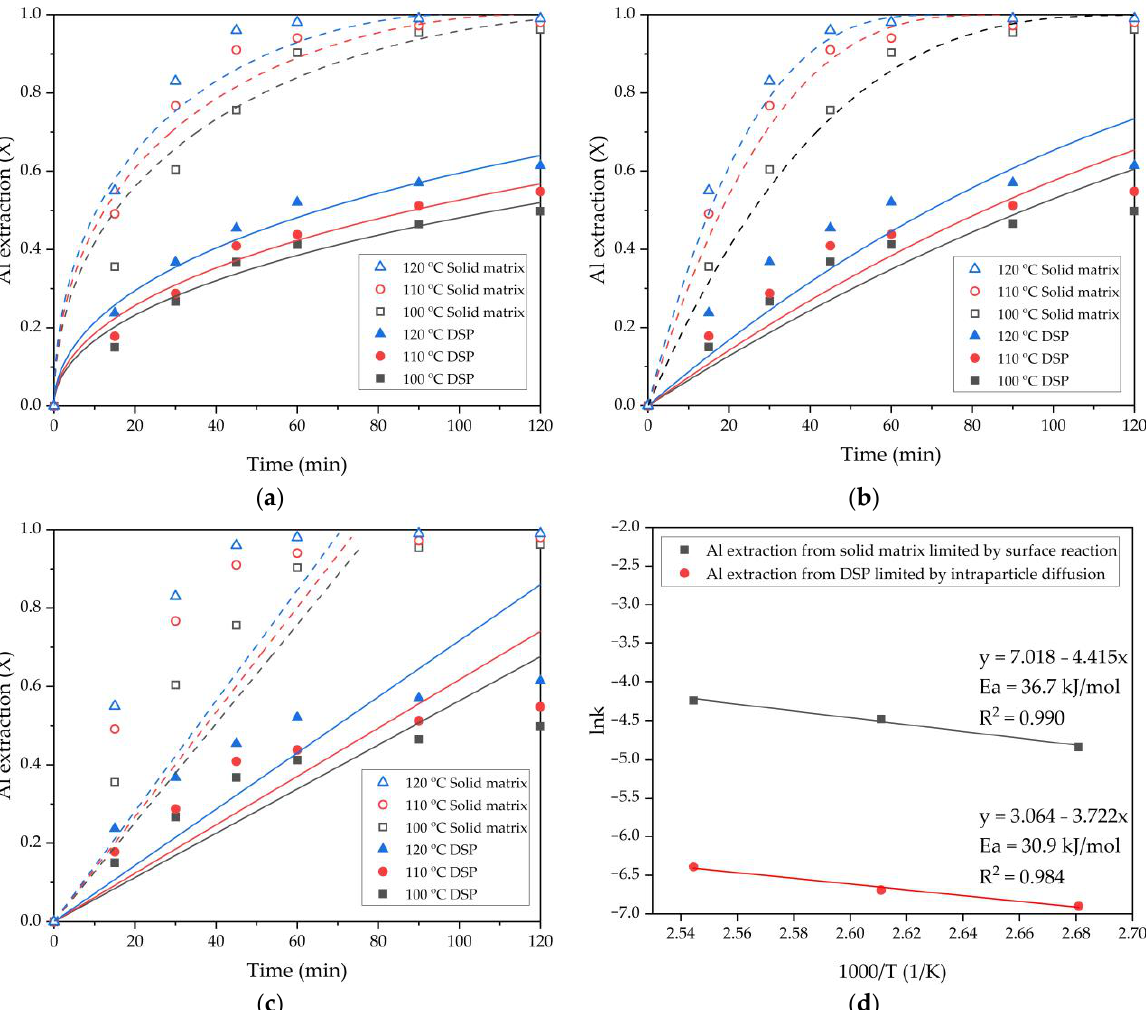
Figure 8. The results of fitting the obtained data for the effect of temperature on the Al extraction from the different phases (points) to Equations (12) – (14) (lines): diffusion through the product layer ( a ); the surface chemical reaction ( b ); diffusion through the liquid film ( c ); the apparent rate constants of the Al extraction from the various phases at different temperatures plotted vs. the inverse temperature (Arrhenius plots) ( d